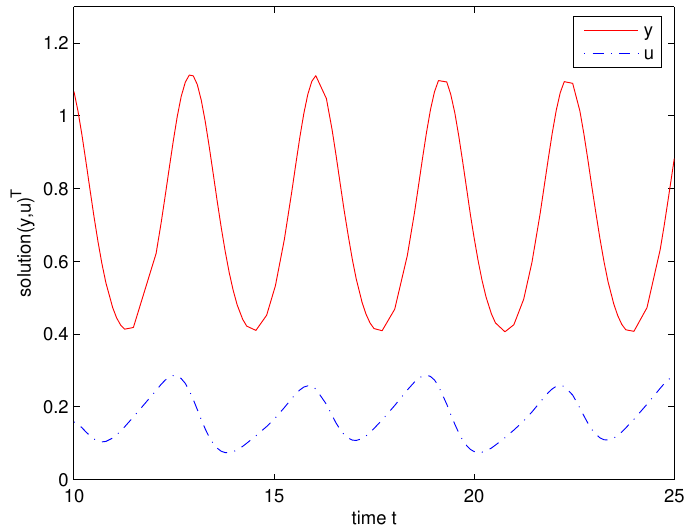
Figure 1. Positive periodic solution ( y ( t ) , u ( t )) (cid:62) of system